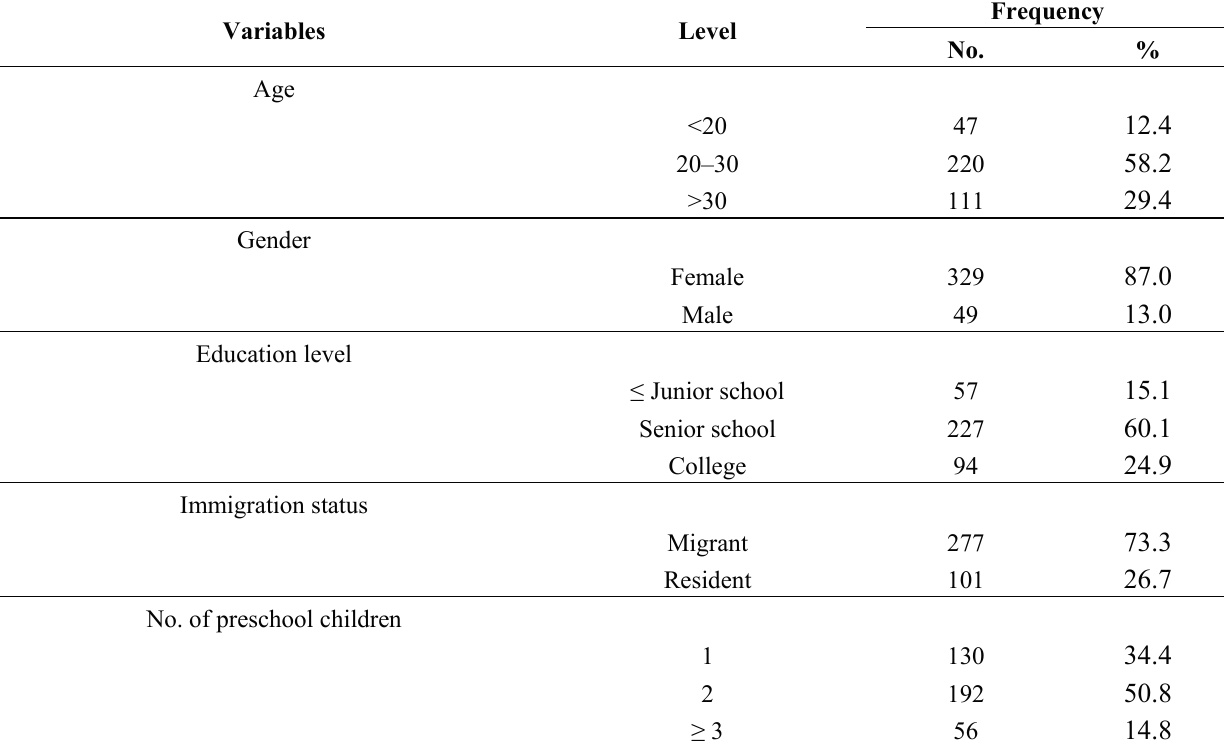
Table 1. Socio-demographic characteristics of the surveyed caregivers (N =